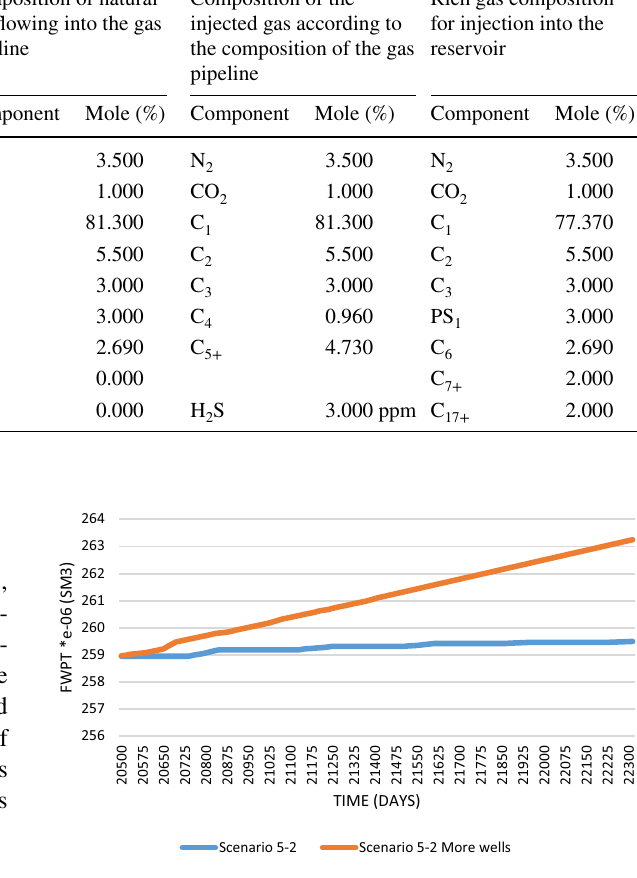
Fig. 8 Field water production rate reduction with increasing number of wells